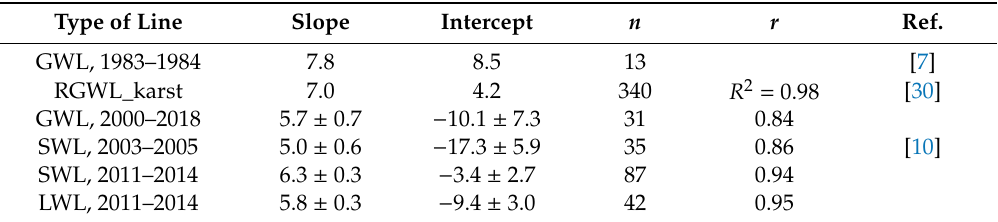
Table 4. Values of the slopes ( a ± σ a ) and intercepts ( b ± σ b ) for the groundwater line (GWL), surface water lines (SWL), and lake water lines